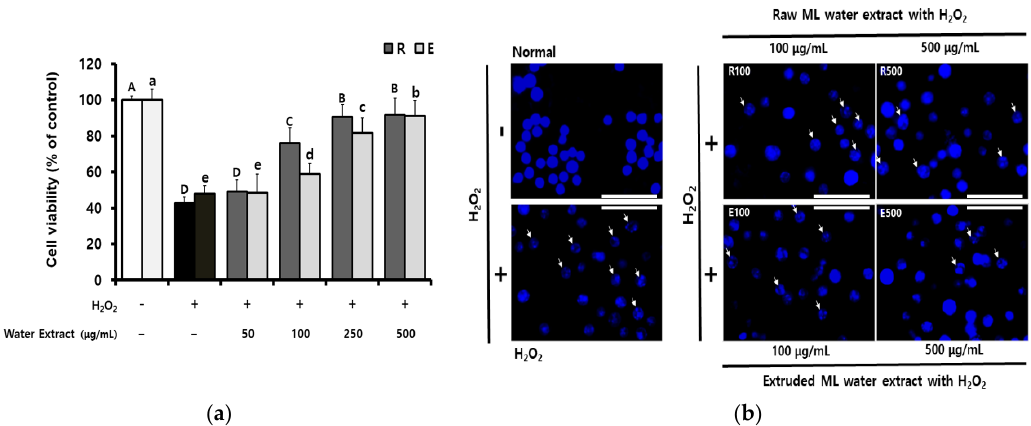
Figure 3. Protective effect of extruded mulberry leaves water extract against H 2 O 2 -induced oxidative damage in RAW 264.7 cells. ( a ) Cells were pretreated with or without extract for 2 h and then cultured with H 2 O 2 for 24 h. ( b ) The cells were stained with Hoechst 33,342 solution and nuclei were observed using a fluorescence microscope (magnification, 400×; scale bar, 50 μ m). ML, mulberry leaves; R, raw ML water extract; E, extruded ML water extract. Data are expressed as the means ± SD. Different uppercase letters for (R) or lowercase letters for (E) represent significant differences between groups according to analysis of variance (ANOVA) followed by Duncan’s multiple range test ( p < 0.05).